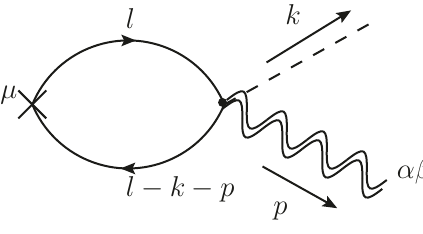
Figure 4 . One-vertex gravitational corrections to the one-axion contributions to the